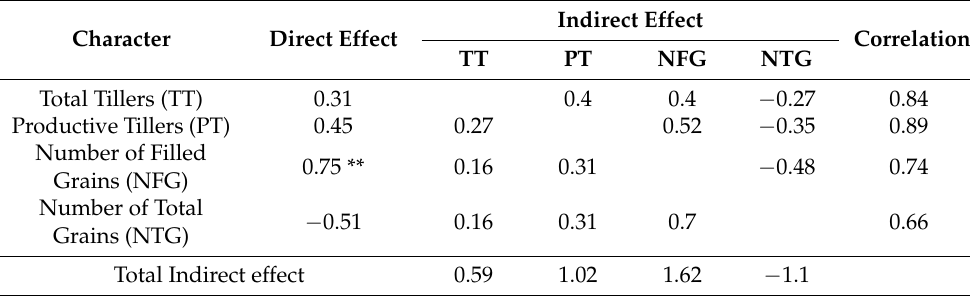
Table 6. Path analysis of several growth characteristics on the rice